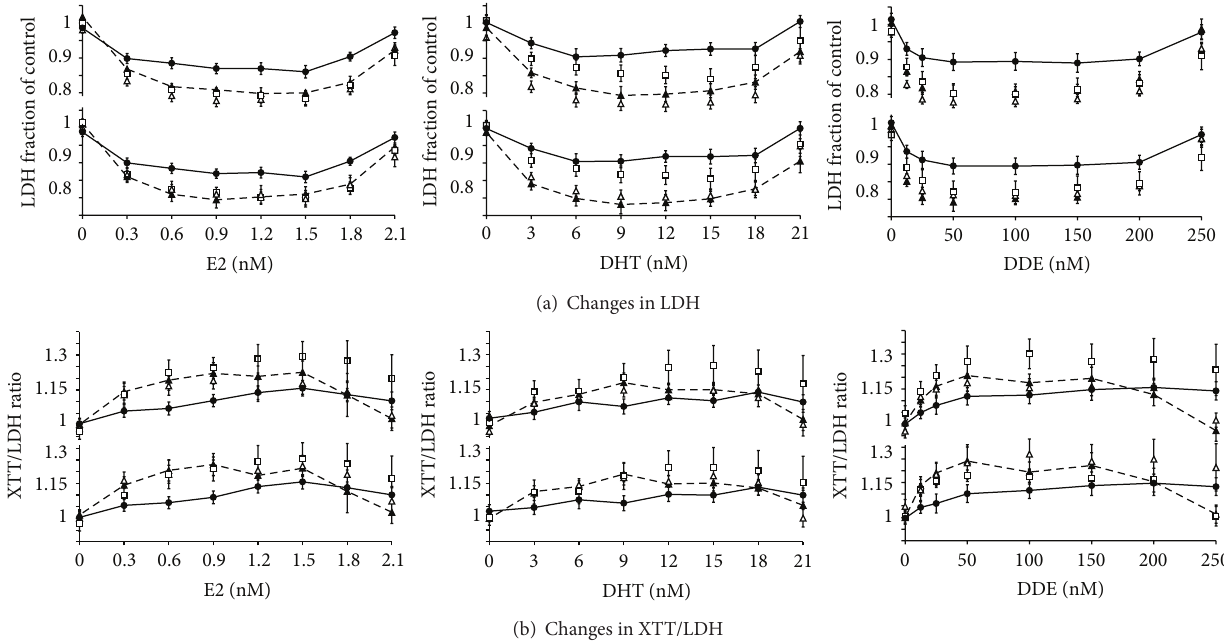
Figure 1: Changes in growth of B-lymphocytes and in their mitochondrial/cell ratio as a function of E2, DHT, and DDE concentrations. The figure shows the changes observed in B cells grown in the presence of E2, DHT, and DDE. The upper part of each panel shows the populations sorted by gender, with the 10 male AUT ( e ), 10 Con ( ◻ ), 10 Bro ( 󳵳 ), and 10 Sis ( 󳵻 ). The lower part of each panel shows the populations sorted by birth relationship, with the average of 11 AUT ( e ), 11 Con ( ◻ ), 11 Twin ( 󳵳 ), and 11 Sib ( 󳵻 ). The solid and dashed lines represent the AUT and Bro/Twin plots, respectively. (a) shows change in growth of B cells (LDH levels), and (b) shows change in the mitochondria/cell ratio (XTT/LDH), after five days in presence of effectors at listed concentrations as compared to controls. The solid line connects the AUT and the broken line the Bro and Twin, respectively. Error bars represent SEM. ASD: autism spectrum disorder; AUT: B cells from individual with ASD; Bro: B cells from brother of individual with ASD; Con: control B cells from individual with no personal or family history of ASD; DDE: dichlorodiphenyldichloroethylene; DHT: dihydrotestosterone; E2: estradiol; LDH: lactate dehydrogenase; SEM: standard error of the mean; Sib: B cells from phenotypically normal male or female siblings of individual with ASD; Sis: B cells from phenotypically normal sister of individual with ASD; Twin: B cells from phenotypically normal fraternal twin of individual with ASD; XTT: 2,3-bis(2-methoxy-4-nitro-5- sulfophenyl)-2H-tetrazolium-5-carboxanilide; XTT/LDH: ratio of XTT/LDH indicative of mitochondrial function per